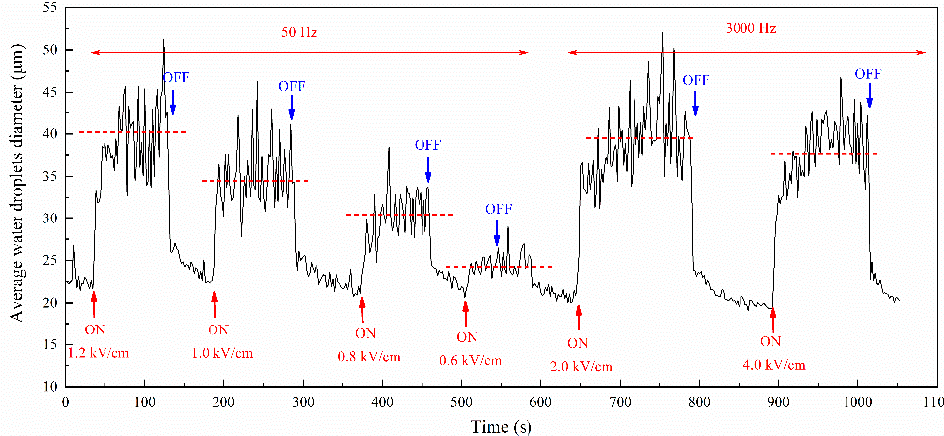
Figure 17. Variations of average water droplet size under different electric field parameters (water content 20%).